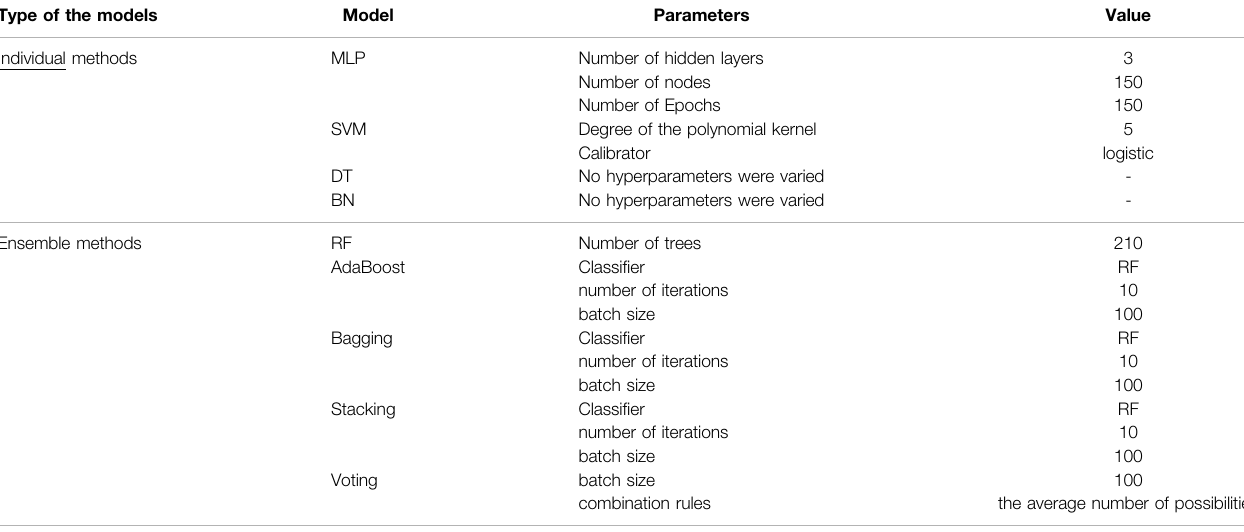
TABLE 6 | The best set of hyperparameters obtained across different ML techniques in training data.